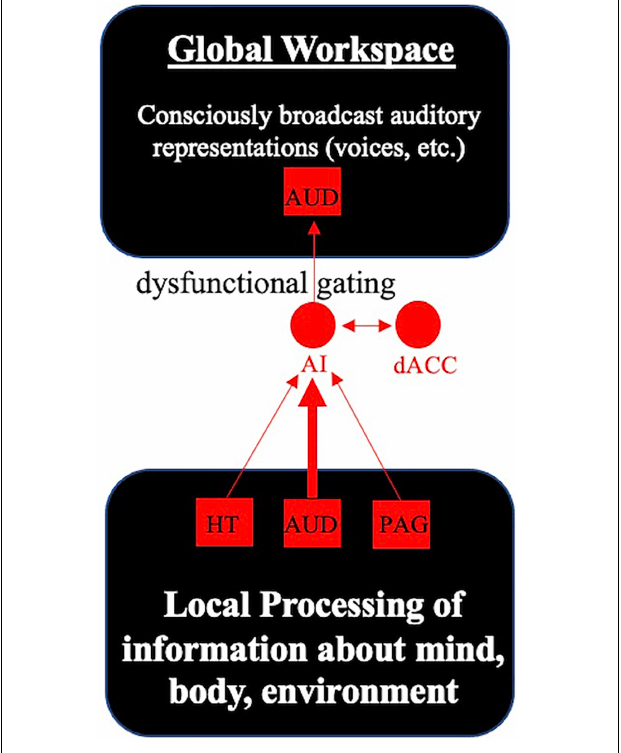
FIGURE 3 | Dysfunctional gatekeeping of the global workspace leads to aberrant perceptions that invade conscious awareness. The anterior insula (AI) continuously monitors inputs from brain areas including the hypothalamus (HT), auditory cortex (AUD) and periaqueductal gray (PAG). Working with the dorsal anterior cingulate cortex (dACC), these cortical hubs of the salience network select the most relevant information (from unimportant background noise) for conscious broadcast to the global workspace. In the case of auditory hallucinations, dysfunctional gatekeeping of the global workspace by the core cortical hubs of the salience network may result in inadvertent broadcast of auditory representations (e.g., voices, sounds) to conscious awareness in some individuals with